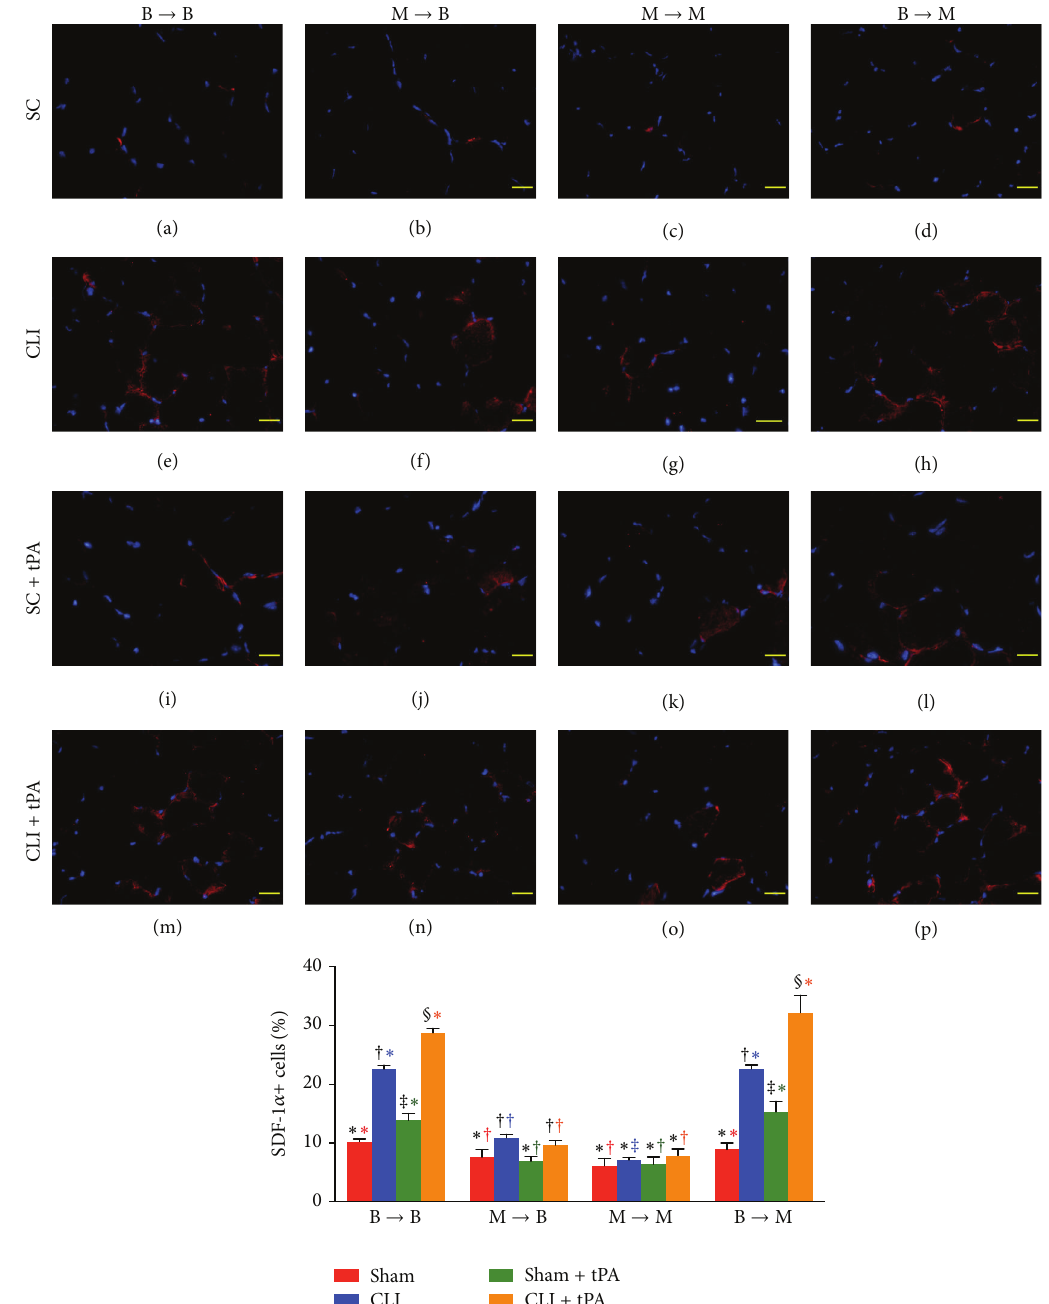
Figure 6: Immunofluorescent (IF) microscopic findings (400x) of stromal cell-derived factor- (SDF-) 1 𝛼 + cells in ischemic quadriceps at day 14 after critical limb ischemia (CLI) induction. (a–p) IF microscopic findings of SDF-1 𝛼 + cells in ischemic area in four treatment conditions of four groups. (1) Statistical analysis for subgroups of each group. (1) In B → B group, subgroups with different black symbols ( ∗ , † , and ‡ ), 𝑝 < 0.05 . (2) In M → B group, subgroups with different black symbols ( ∗ , † ), 𝑝 < 0.05 . (3) In M → M group, 𝑝 > 0.5 . (4) In B → M group, subgroups with different black symbols ( ∗ , † , and ‡ ), 𝑝 < 0.05 . (2) Statistical analysis for group comparison with respective treatment condition. (1) For SC subgroup (red bar chart), groups with different red symbols ( ∗ , † ), 𝑝 < 0.05 . (2) For CLI subgroup (blue bar chart), groups with different blue symbols ( ∗ , † , and ‡ ), 𝑝 < 0.05 . (3) For SC + tPA subgroup (green bar chart), groups with different green symbols ( ∗ , † ), 𝑝 < 0.05 . (4) For CLI + tPA subgroup (orange bar chart), groups with different orange symbols ( ∗ , † ), 𝑝 < 0.05 . All statistical analyses were performed by one-way ANOVA followed by Bonferroni multiple comparison post hoc test. SC = sham control; tPA = tissue plasminogen activator. 𝑛 = 6 for each